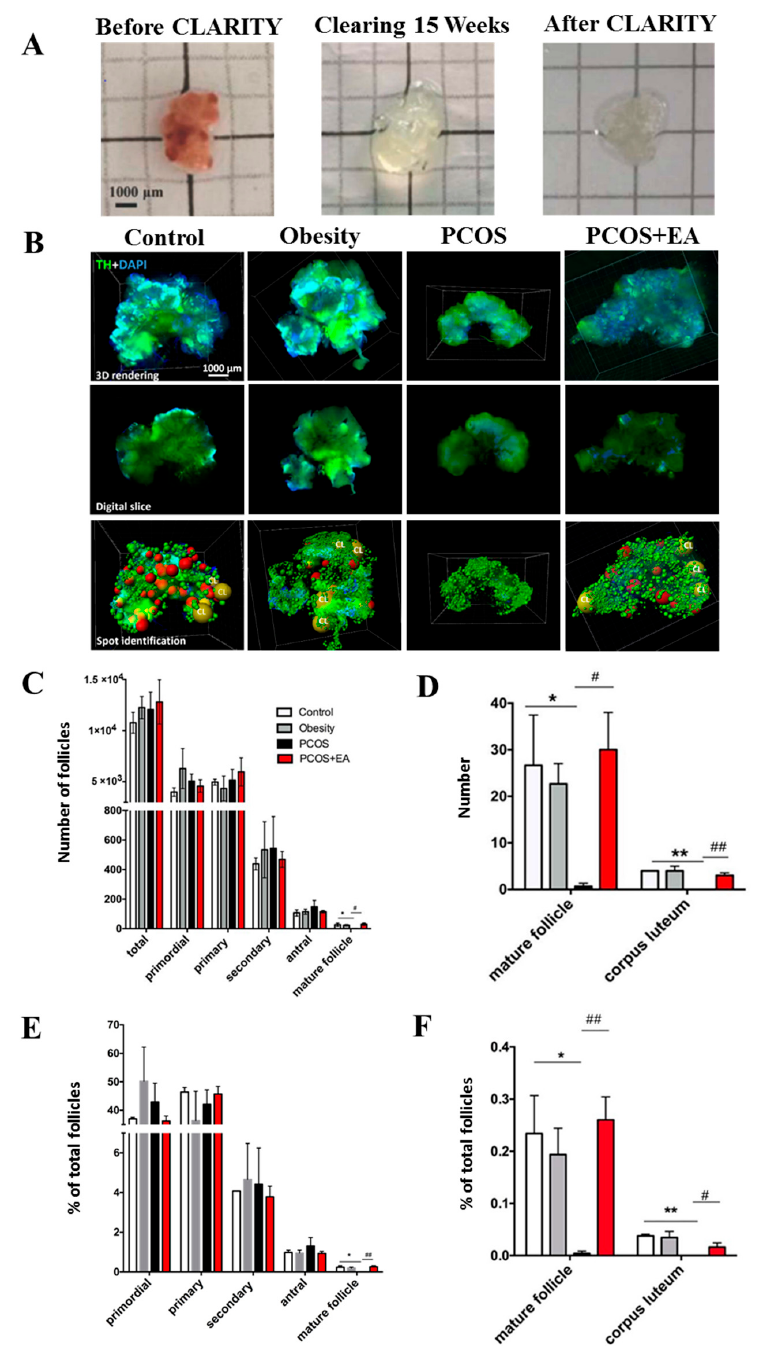
Figure 2. CLARITY shows that EA increases the numbers of mature follicles and Cl in the ovaries from PCOS-like rats. ( A ) The clarification process of a rat ovary. ( B ) Ovaries from rats in the different groups after CLARITY processing and immunostaining using specific antibodies followed by data transformation using the Imaris Spot algorithm. Upper panels: 3D rendering of whole ovary images; middle panels: digital slices showing follicles at individual planes; lower panels: Data transformation into spot graphs following the identification of follicles using specific markers. Background staining using tyrosine hydroxylase antibodies provided outlines for the identification of all follicles. Red spots represent preovulatory follicles. CL, corpus luteum. ( C ) The numbers of follicles at different developmental stages in the different groups. ( D ) The numbers of mature follicles and corpora lutea. ( E ) The ratio of the different follicle stages in each group. ( F ) The ratio of mature follicles and CL. * p < 0.05 and ** p < 0.01 vs. the Control group; # p < 0.05 and ## p < 0.01 vs . the PCOS group.